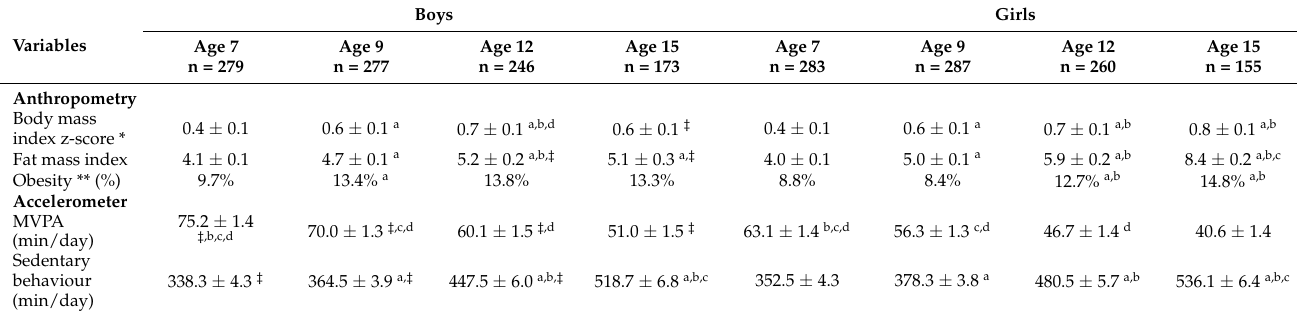
Table 1. Anthropometry and physical activity (Mean ± SE) of study participants at the four waves by sex.